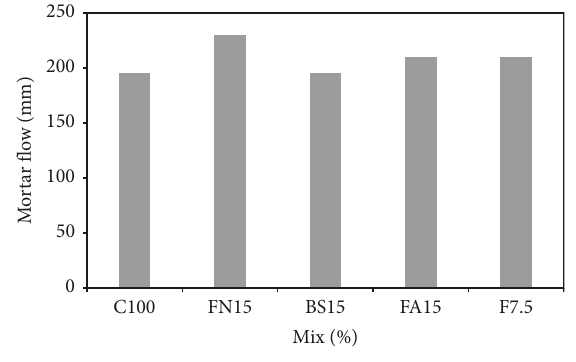
Figure 6: Mortar flow (Series I). Figure 7: Mortar flow (Series II).